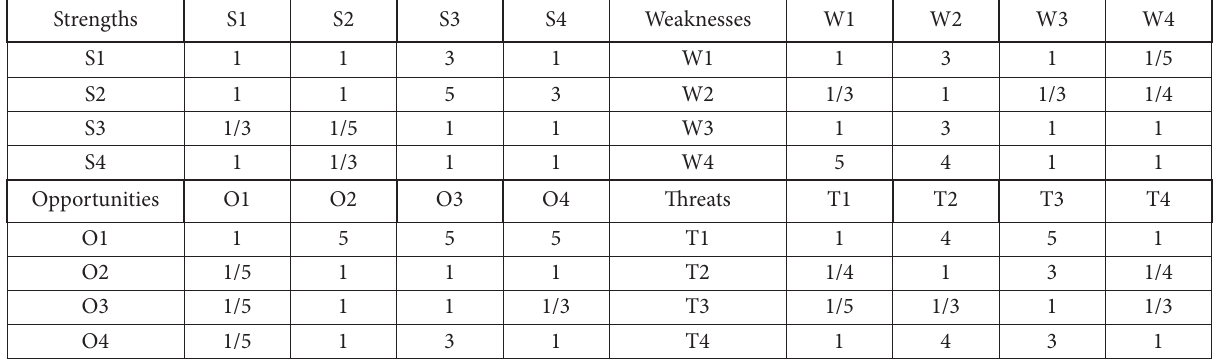
Table A1. Matrix of paired comparisons for SNC (one expert)